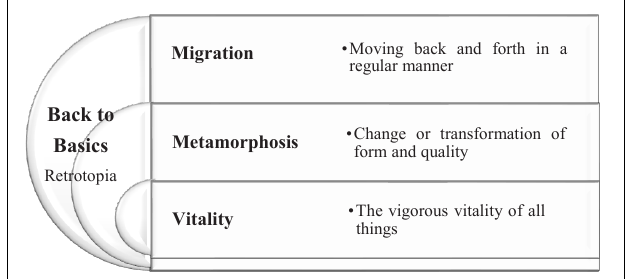
FIGURE 4 | Major theme and sub-theme association diagram and meaning.